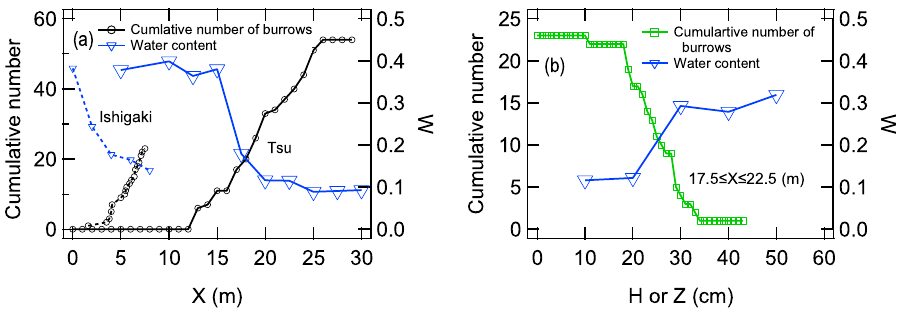
Fig 7. Burrow characteristics at the beach sites. Panels: (a) Cumulative number of burrows whose entrance positions are closer than the depicted distance from the shoreline ( X ) and the water content of sand at distance X measured from the shorelines (and the depth Z = 10 cm) at the Tsu site (solid curves) and Ishigaki site (dashed curves). (b) Cumulative number of burrows shallower than depth H at 17.5–22.5 m distance from shoreline (green squares) and water content of sand versus tunnel depth at 20 m from the shoreline (blue triangles), measured at Tsu